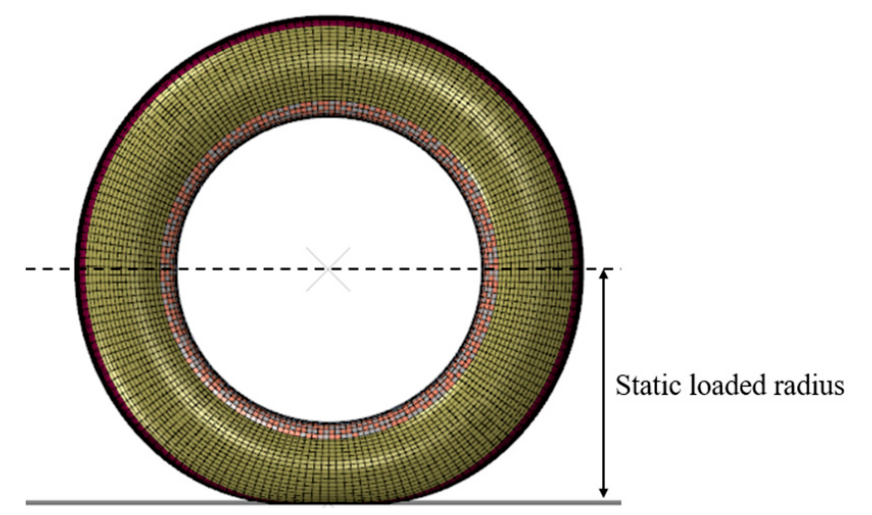
Figure 7. The relationship between the sinkage of aircraft tire and vertical load.